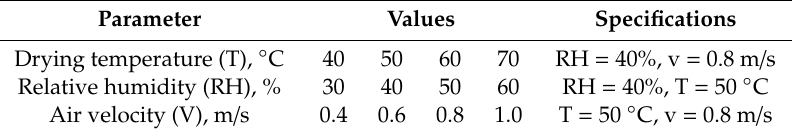
Table 1. Summarization of the operating cases in the lab experiment.